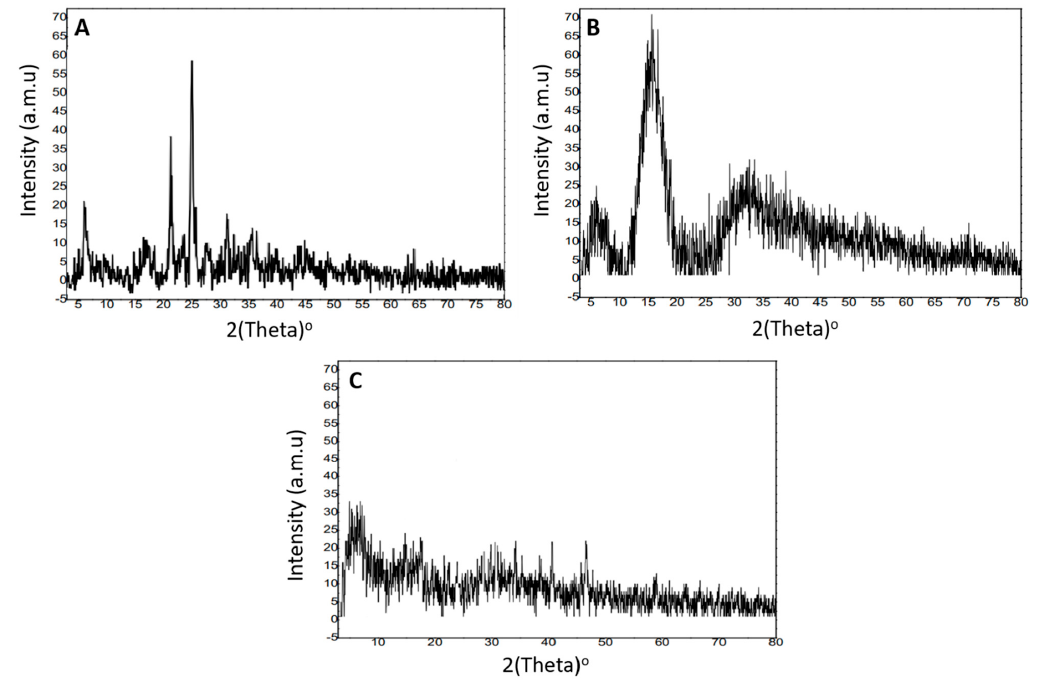
Figure 5. X-ray diffractogram of ( A ) tofacitinib, ( B ) unloaded microparticles, ( C ) drug-loaded MU- CHI-Co-poly (MAA) hydrogel microparticles.